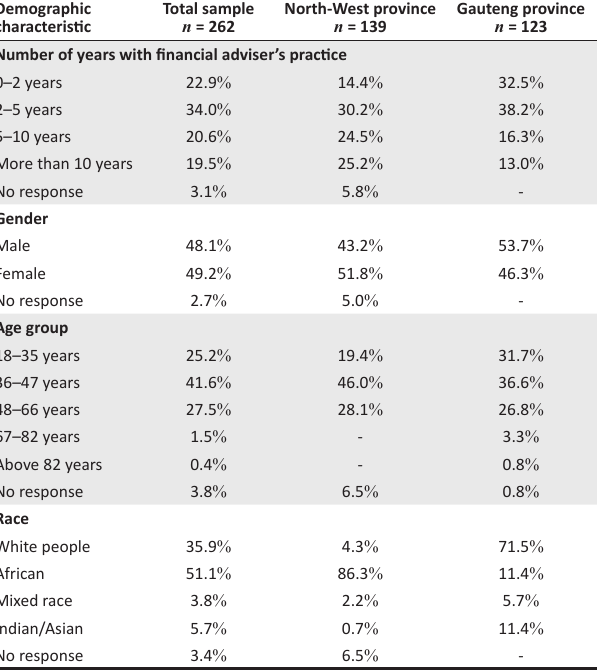
TABLE 1: Demographic profile of